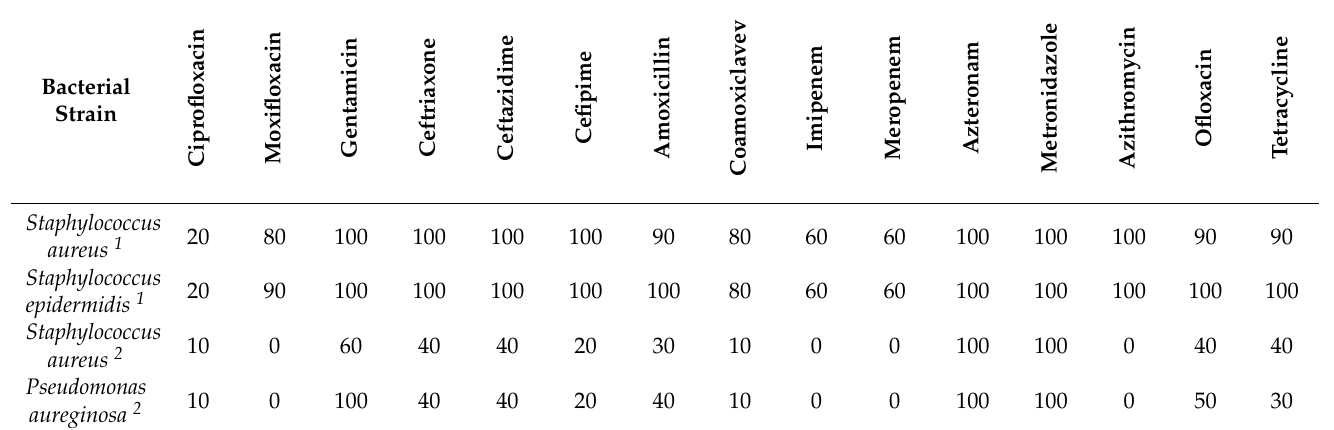
Table 2. Antibiogram profiles of tested strains.